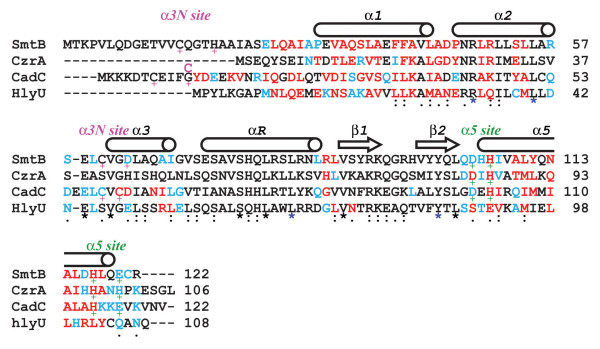
Alignment of the Vc-HlyU sequence with those of templates SmtB from Synechococcus PCC7942, CzrA from Staphylococcus aureus, and CadC from Staphylococcus aureus pI258. Secondary structural elements are shown (α-helices as cylinders and β-strands as arrows) and labeled (α4 is the DNA-recognition helix, αR). Metal binding sites α3N and α5 are marked with plus (+) sign in magenta and green color, respectively. Residues which formed the homodimeric interface are shown in colors, core-residues and rim-residues [37] are shown in red and sky-blue, respectively. Conserved residues are denoted by asterix (*), while residues conserved among all the SmtB/ArsR family members are colored in blue asterix (*). The wild-type CadC has a Cys in position 11, which was Gly in the recombinant protein.